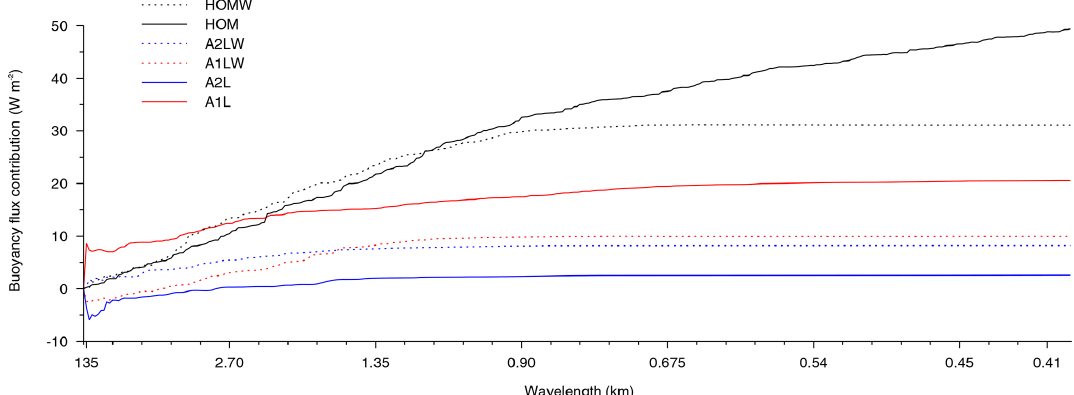
Figure 12. The cumulative contribution of the buoyancy flux of all wavelength (km) at a height of 50m for runs HOM, HOMW, A1L, A2L, A1LW, and